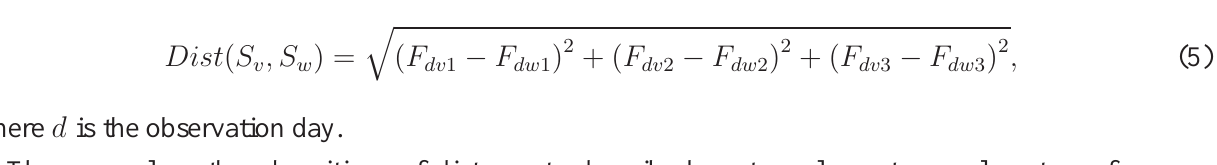
Figure 11. Three observation points 𝑆